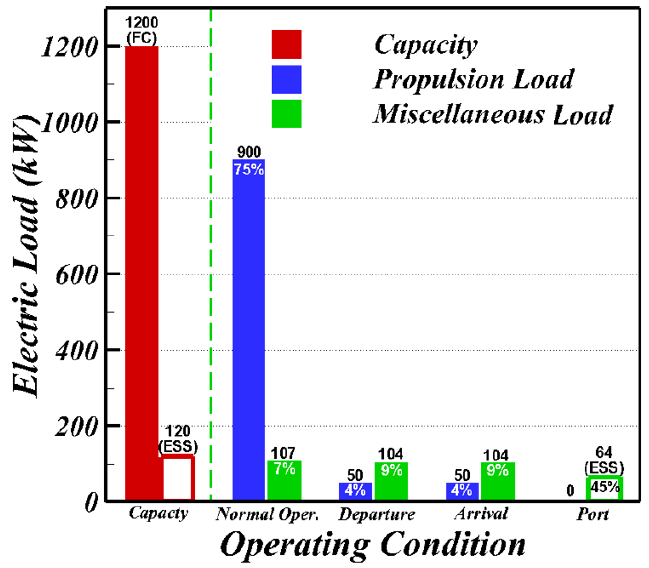
Figure 10. Results of the electric load analysis during the ship operation.